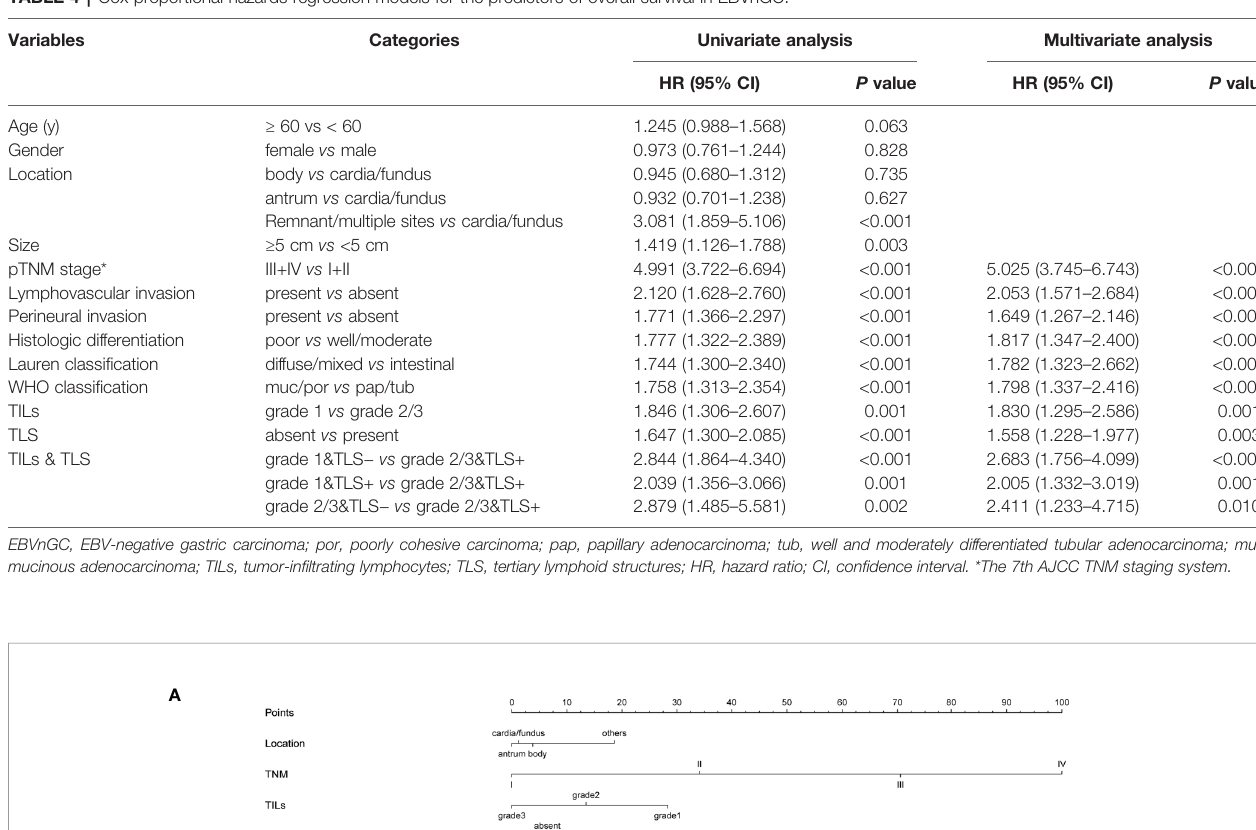
TABLE 4 | Cox proportional hazards regression models for the predictors of overall survival in EBVnGC.